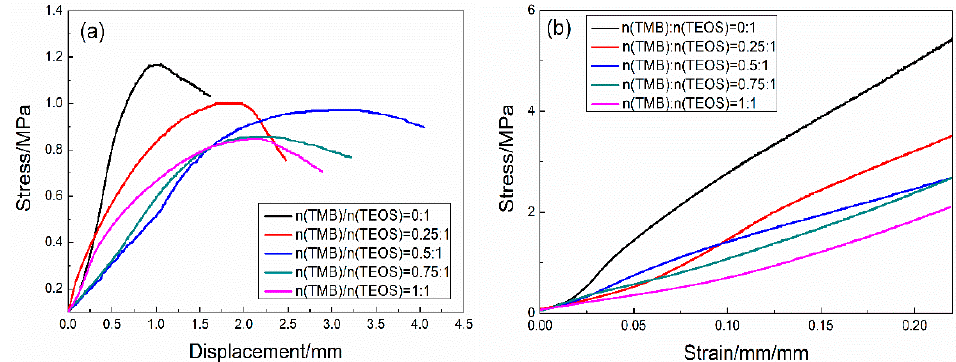
Figure 7. Bending stress-displacement curves ( a ) and compression stress-strain curves ( b ) of SiBCO aerogel composites with varying TMB content.